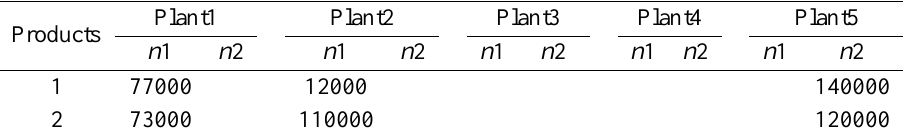
Table 13. Production quantity in planning period